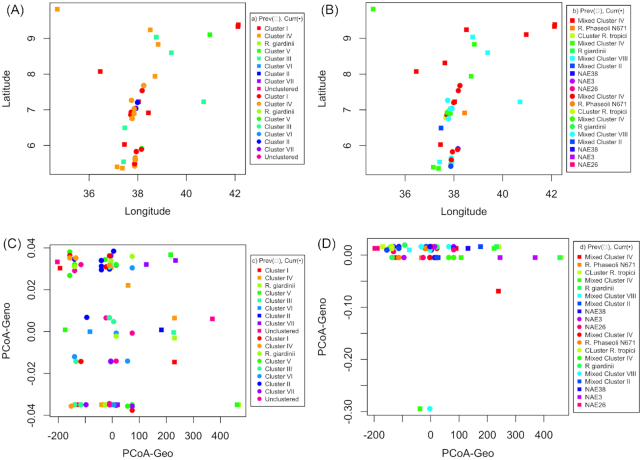
Distribution of genospecies and symbiovars in plane and PCoA. (A) Distribution of genospecies. (B) Distribution of symbiovars. (C) PCoA of genospecies and geographic distances. (D) PCoA of symbiovars and geographic distances. ‘Prev.’ = previous strains; ‘Curr.’ = current strains. The clusters in the legend represent the genetic groups of the rhizobial isolates based housekeeping gene phylogeny (a, b) and symbiotic gene nodC phylogeny (b, d). The PCoA-Geo represents geographic coordinates, while the PCoA-Geno represents the genetic distances between the strains. Rectangular dots represent strains from previous (Prev) culture collection and circular dots indicate strains from current (Curr) culture collection.